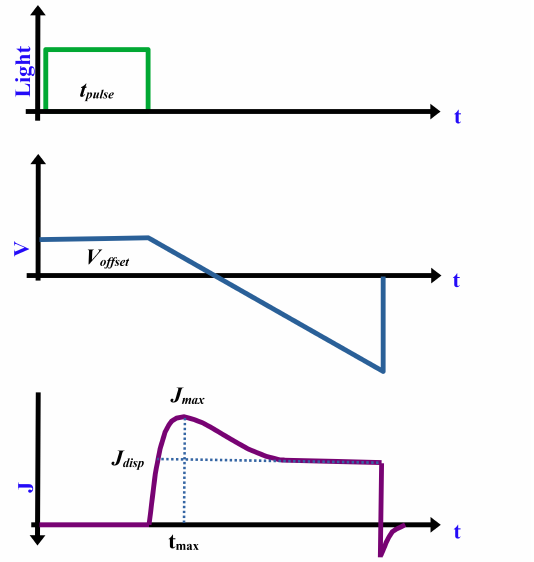
Figure 4. Graphical explanation of photo-CELIV technique